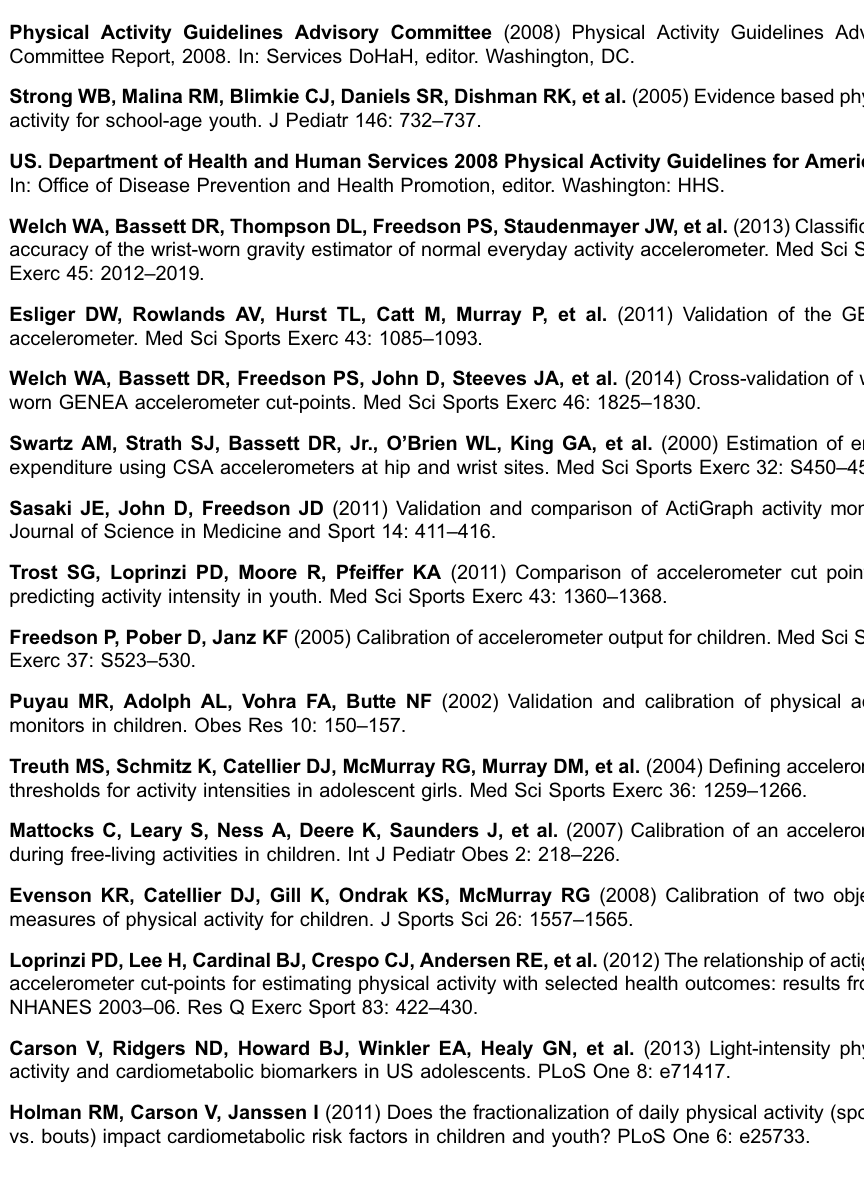
S6 Table. Percentiles for Minutes of Light Physical Activity in US Girls Ages 6– 19 ( N 5